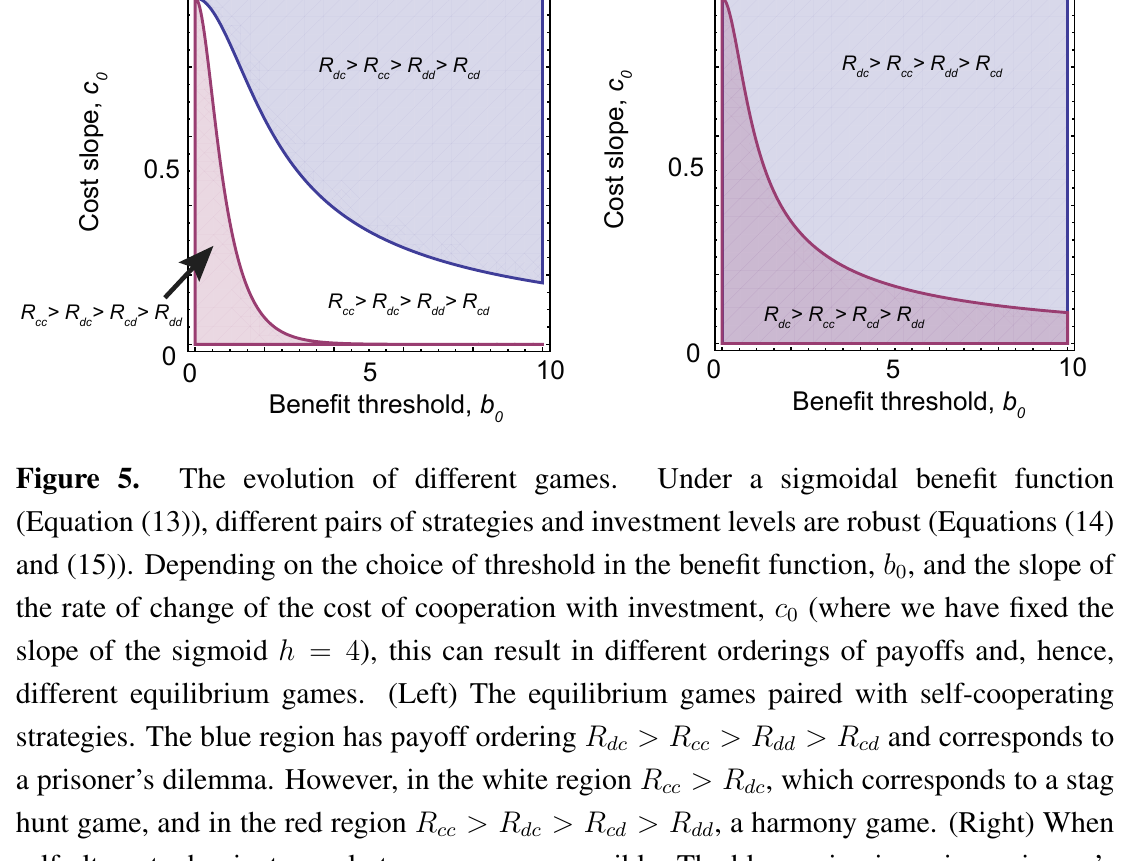
, and the slope of 0 (where we have fixed the 0 > R > R > R and corresponds to dc cc dd cd > R , which corresponds to a stag cc dc > R > R > R , a harmony game. (Right) When cc dc cd dd > R > R > R and is a snowdrift dc cc cd dd